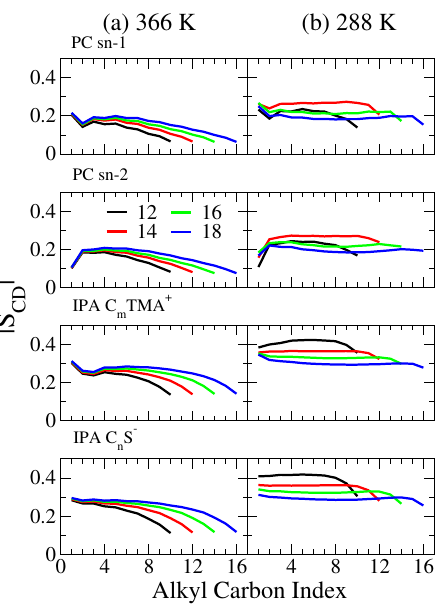
Figure 4. Deuterium order parameter, | S CD | , profiles at ( a ) 366 and ( b ) 288 K for the sn-1 and sn-2 chains of PC and the alkyl chains of cationic and anionic IPA components. The color codes for the alkyl chain lengths are black, red, green, and blue for n = 12, 14, 16, and 18, respectively.